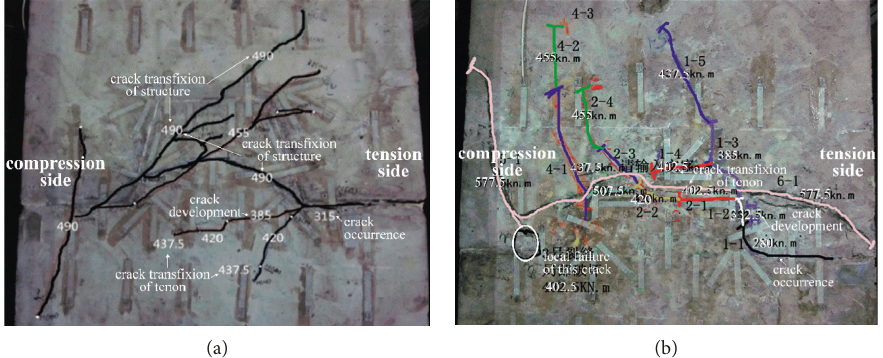
Figure 16: Crack development with loading for different joint lengths. (a) 195mm, (b)